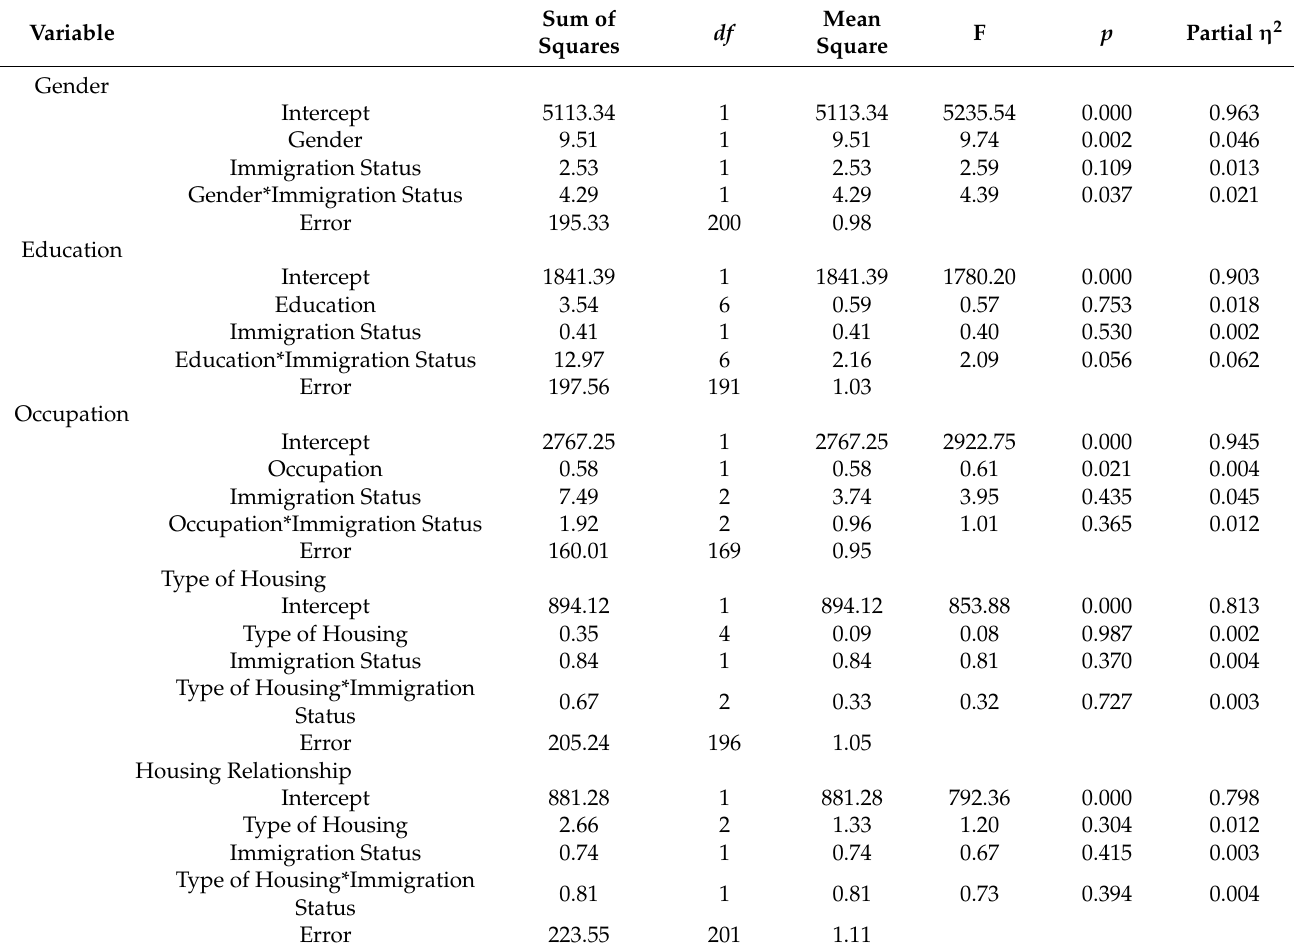
Table 2. 2-way Anova Gender, Education, Occupation, Type of Housing, Housing Relationship, and Immigration